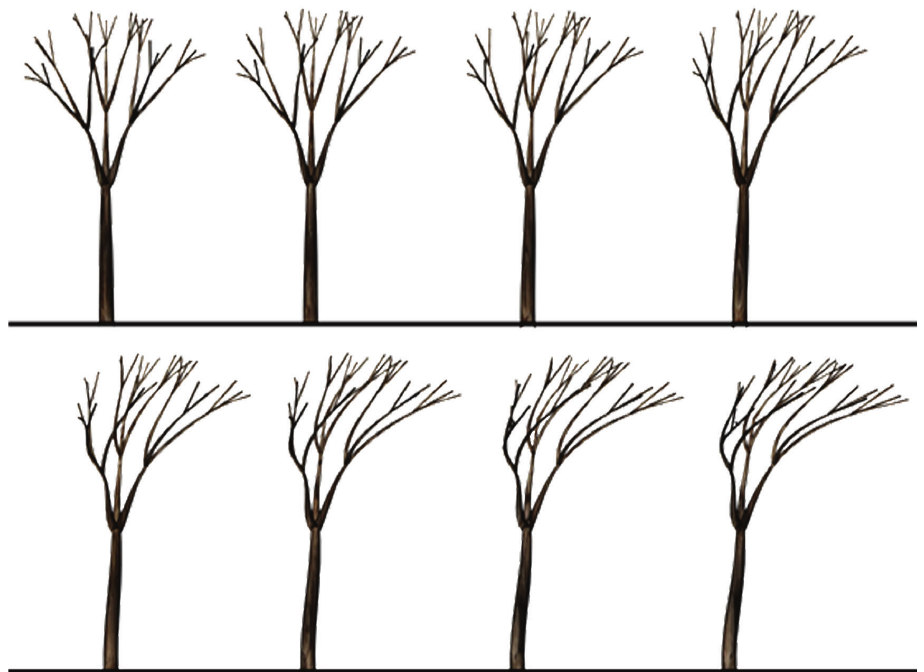
Figure 10: Eight states extracted from the 40 seconds animation of a